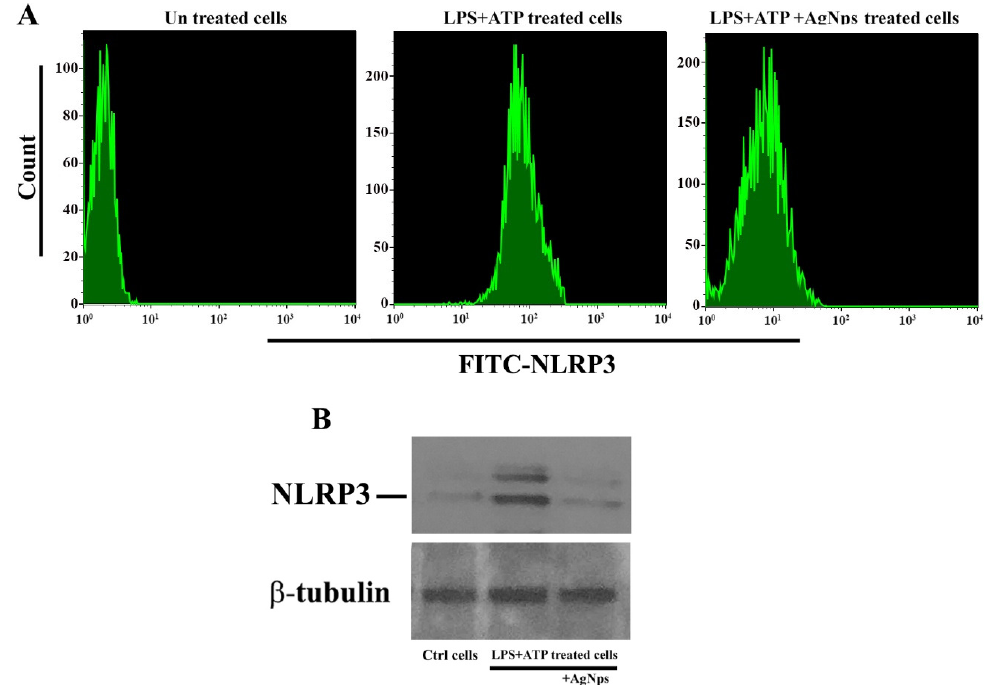
Figure 11. AgNPs reduce NLRP3 inflammasome activation. ( A ), Flow cytometry analysis for NLRP3 in BMDMs following treatment with LPS+ATP, with and without treatment with 5 μ gmL − 1 AgNPs. ( B ), Westren blot analysis of NLRP3 protein. Cells left untreated as control or treated with LPS+ATP in absence and absence of AgNPs at a concentration of 5 μ gmL − 1 .